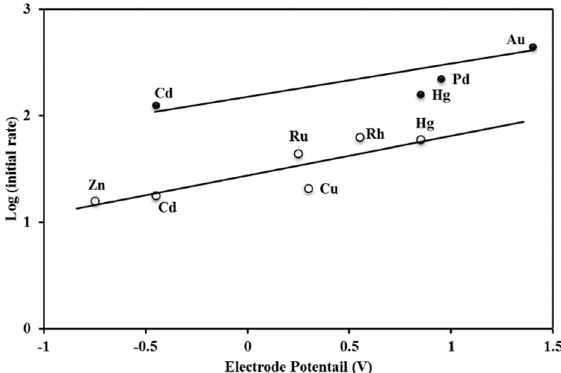
Figure 3. The correlation between catalytic activity and standard electrode potential of metal cations in acetylene hydrochlorination [16].